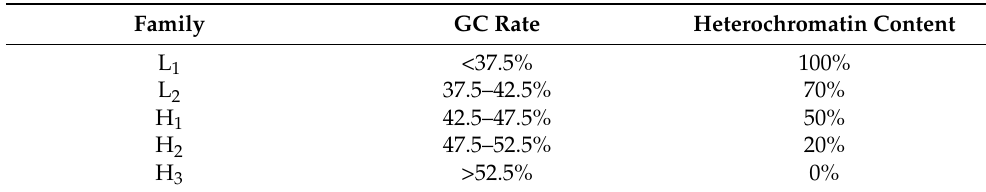
Table 1. Properties of the different isochore families in terms of GC rate, as well as the associated heterochromatin/euchromatin